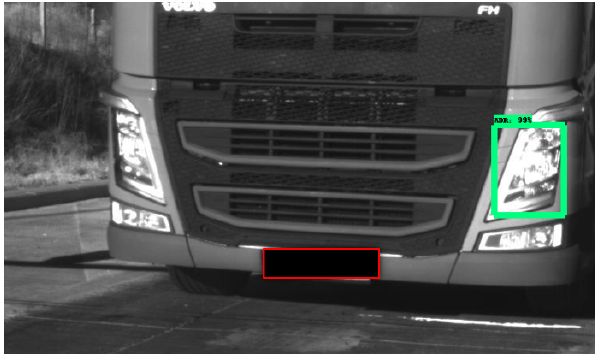
Figure 7. Non-ADR sign, from the dataset of the 250 ADR images detected as an ADR sign (green image box), false positive detection